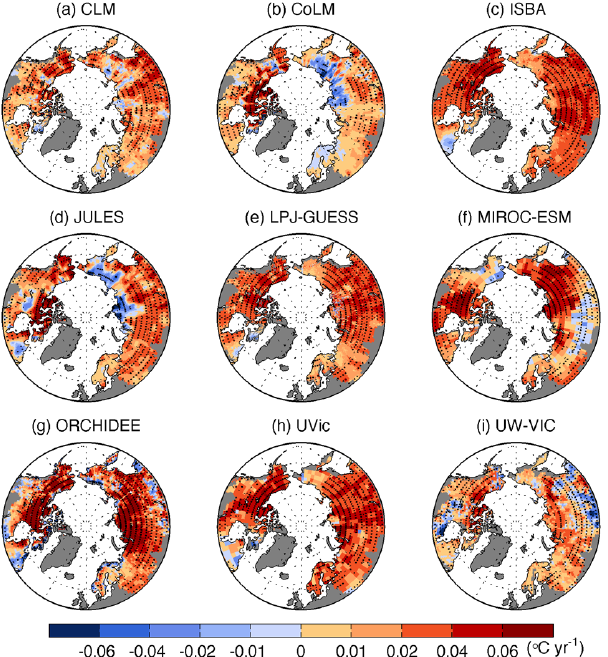
Figure 4. Spatial distributions of trends of annual T s at 20cm over boreal regions from 1960 to 2000 in (a) CLM, (b) CoLM, (c) ISBA, (d) JULES, (e) LPJ-GUESS, (f) MICRO-ESM, (g) ORCHIDEE, (h) UVic, and (i) UW-VIC models. The black dots indicate regions with significant trends of T s ( P <0.05). Note that extreme values outside of the range of − 0.06 to 0.06 ◦ Cyr − 1 are shown in the deep- est blue and red in the color bar.